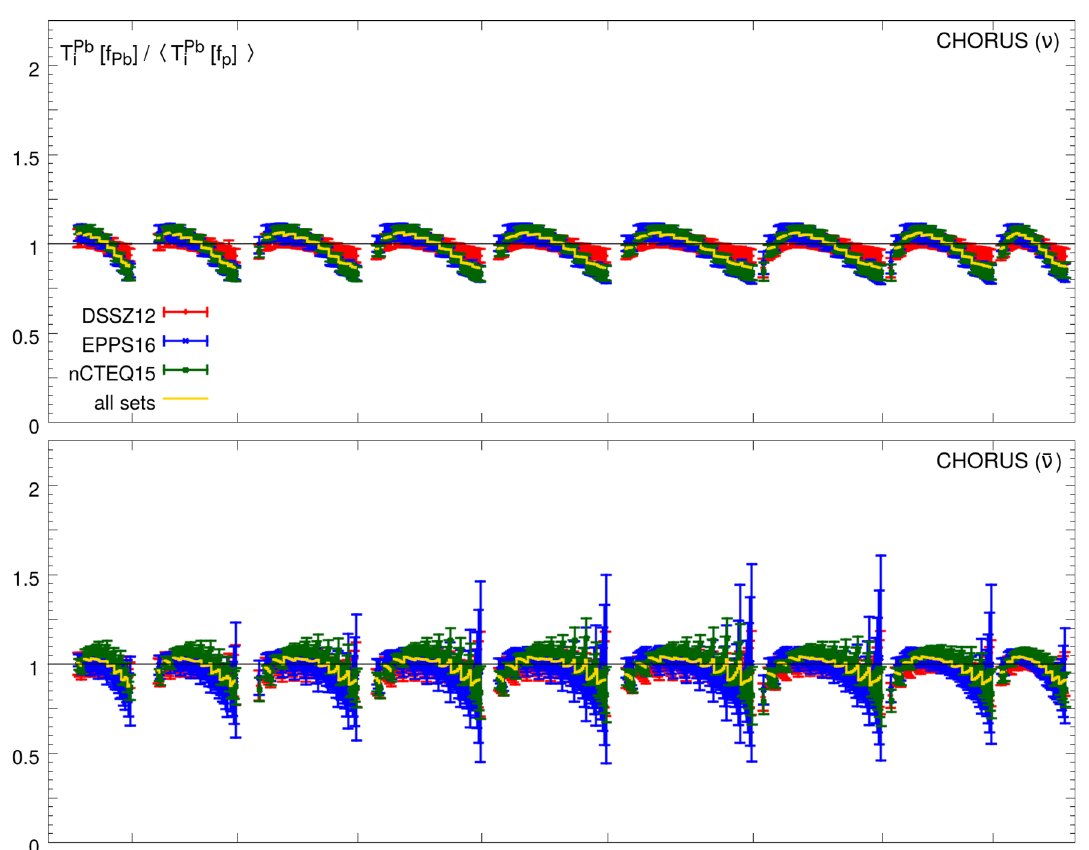
Fig. 4 The ratio between the CHORUS observable computed with [ f ] , and the central prediction with proton PDFs, nuclear PDFs, T Pb Pb i (cid:2) T Pb [ f ](cid:3) , in the case of neutrino (top) and antineutrino (bottom) p i beams. Results from the DSSZ12, EPPS16 and nCTEQ15 sets are dis- played separately. The ratio between the nuclear and the proton expec- tation values is also shown, averaged over the combination of all repli-